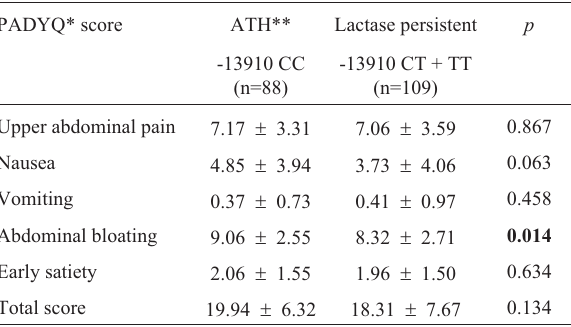
Table 2 - Total and individual symptom scores (PADYQ) according to lactase activity status (-13910C/T SNP genotypes). PADYQ*